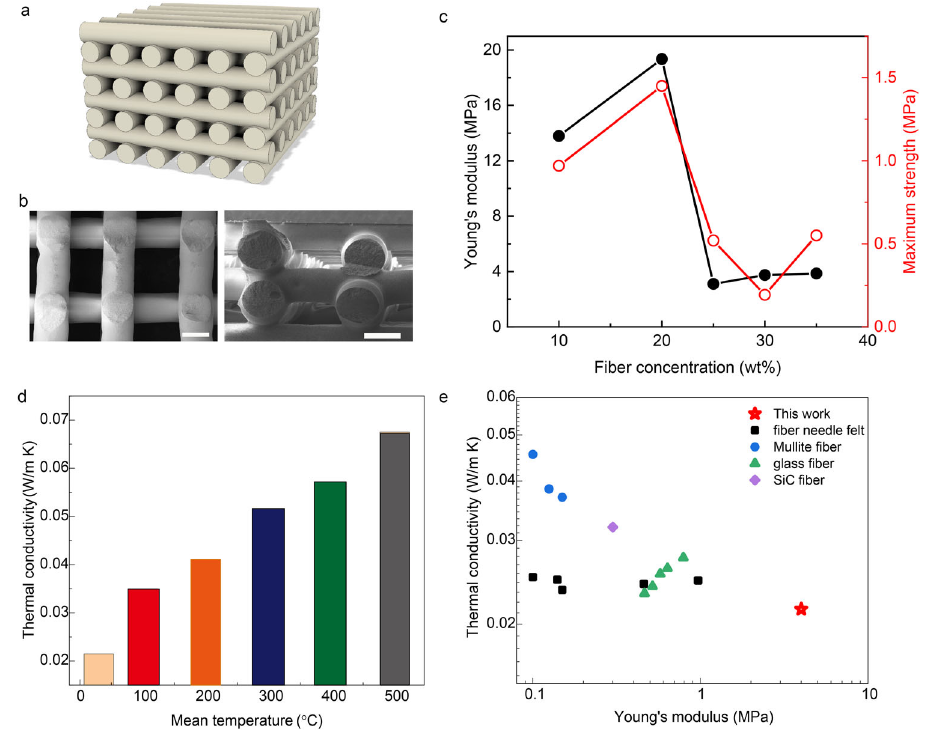
Fig. 3 | Characteristics of DIW-silivoxels. a The CAD model of the hollow pile-up structure. b SEM images of the hollow wood-pile structure of DIW-silivoxels. The scale bars are 400 μ m. c Young ’ s modulus and maximum strength vs. fi ber